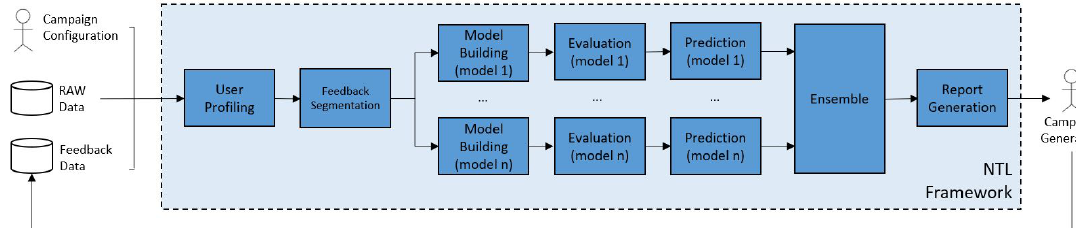
Figure 2. New system architecture. In comparison to our previous framework (Figure 1), we segment our data according to the NTL reported, build independent models and merge them using a bucket-of-models approach. The Report Generation module provides explanations to predicted